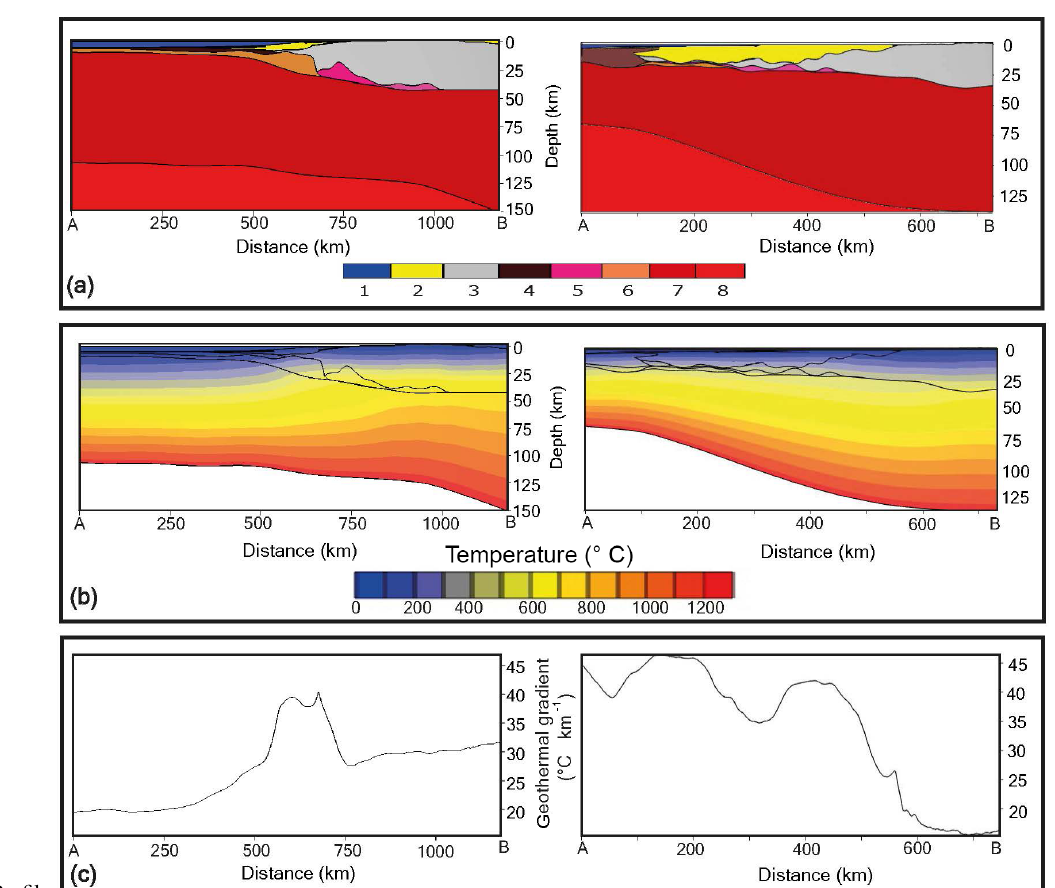
Figure 11. Structural–thermal cross section and corresponding average geothermal gradient at the SW African passive margin (left) and Norwegian continental margin (right) after Scheck-Wenderoth et al. (2007); Scheck-Wenderoth and Maystrenko (2008); Maystrenko et al. (2013). (a) Structural crustal cross section along the A–B profile (Figs. 4a and 7a). Numbers near color legend for individual layers: (1) water, (2) sediments, (3) crystalline continental crust, (4) oceanic crust, (5) high-density continental crust, (6) high-velocity high-density lower crustal layer, (7) low-density mantle, (8) normal-density mantle. (b) Temperature distribution within the A–B cross section. (c) Calculated average geothermal gradient along the A–B cross